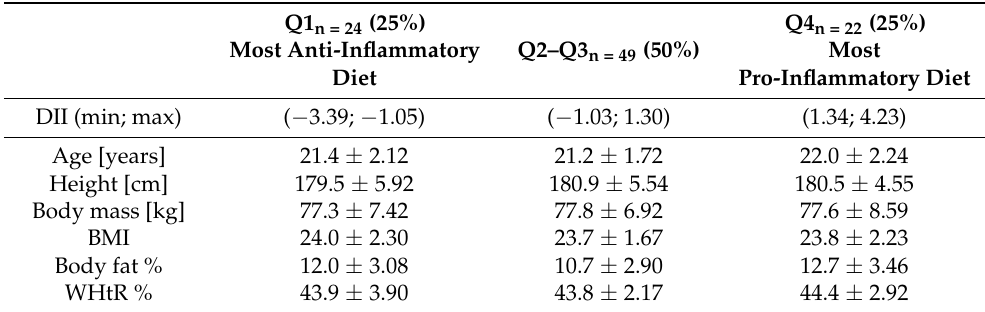
Table 1. Anthropometric characteristics of participants (mean ±